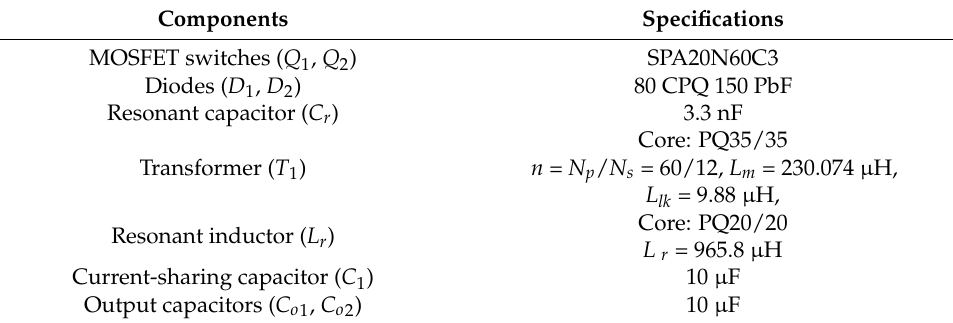
Table 2. Components used in the proposed LED